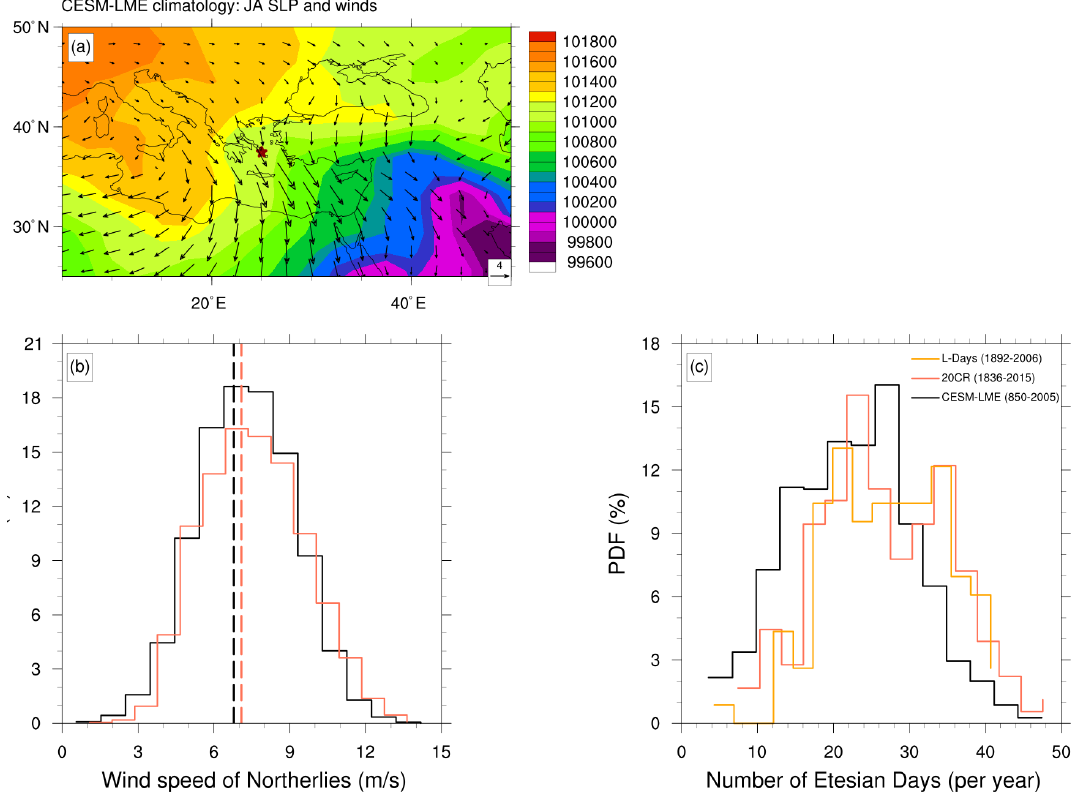
Figure 1. Climatology and variability in the Etesians. (a) Climatology of July and August (JA) SLP (Pa; contours) and 10m wind (ms − 1 ; arrows) in CESM-LME over the 1980–2005 period. The red star symbol indicates the fixed grid point (37.5 ◦ N, 25.0 ◦ E) in the central Aegean Sea used for calculating the number of Etesian days (NED) and wind speed (WSP). (b) Probability density functions of northerly (315–45 ◦ ) JA WSP for CESM-LME (black) and 20CR (red). Dash lines denote the median northerly WSP of 6.8 and 7.1ms − 1 for CESM-LME and 20CR, respectively. (c) Probability density functions of NED for CESM-LME, 20CR and L-days. Probability density functions (PDFs) are calculated for the full period of each dataset. CESM-LME is represented by the all-forcing ensemble member